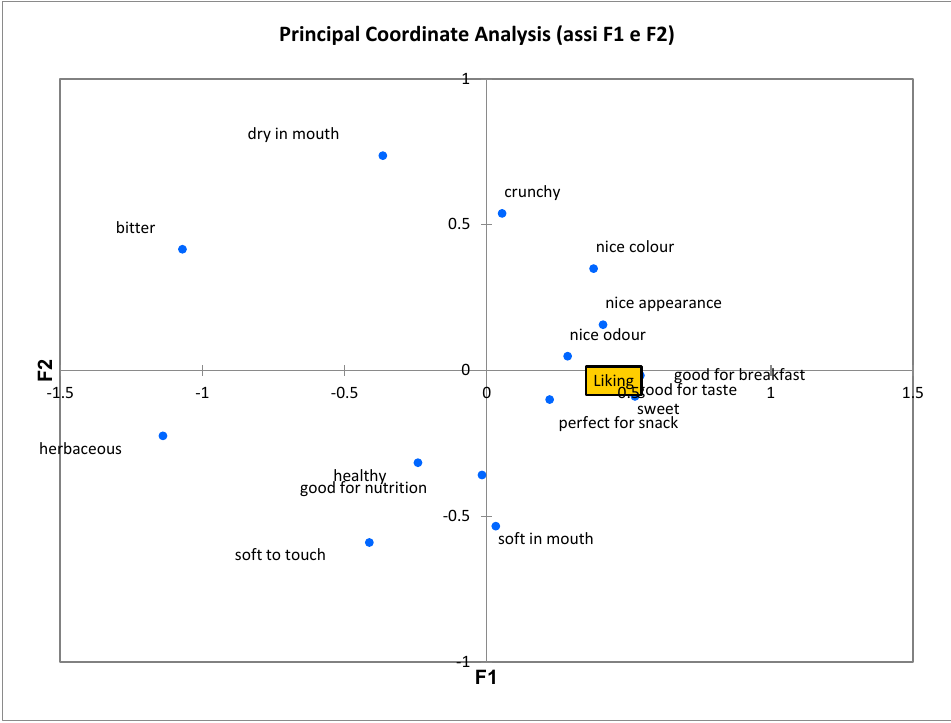
Figure 3. Principal coordinate analysis of ladyfinger biscuits made with RF only or at different QF substitution rates.